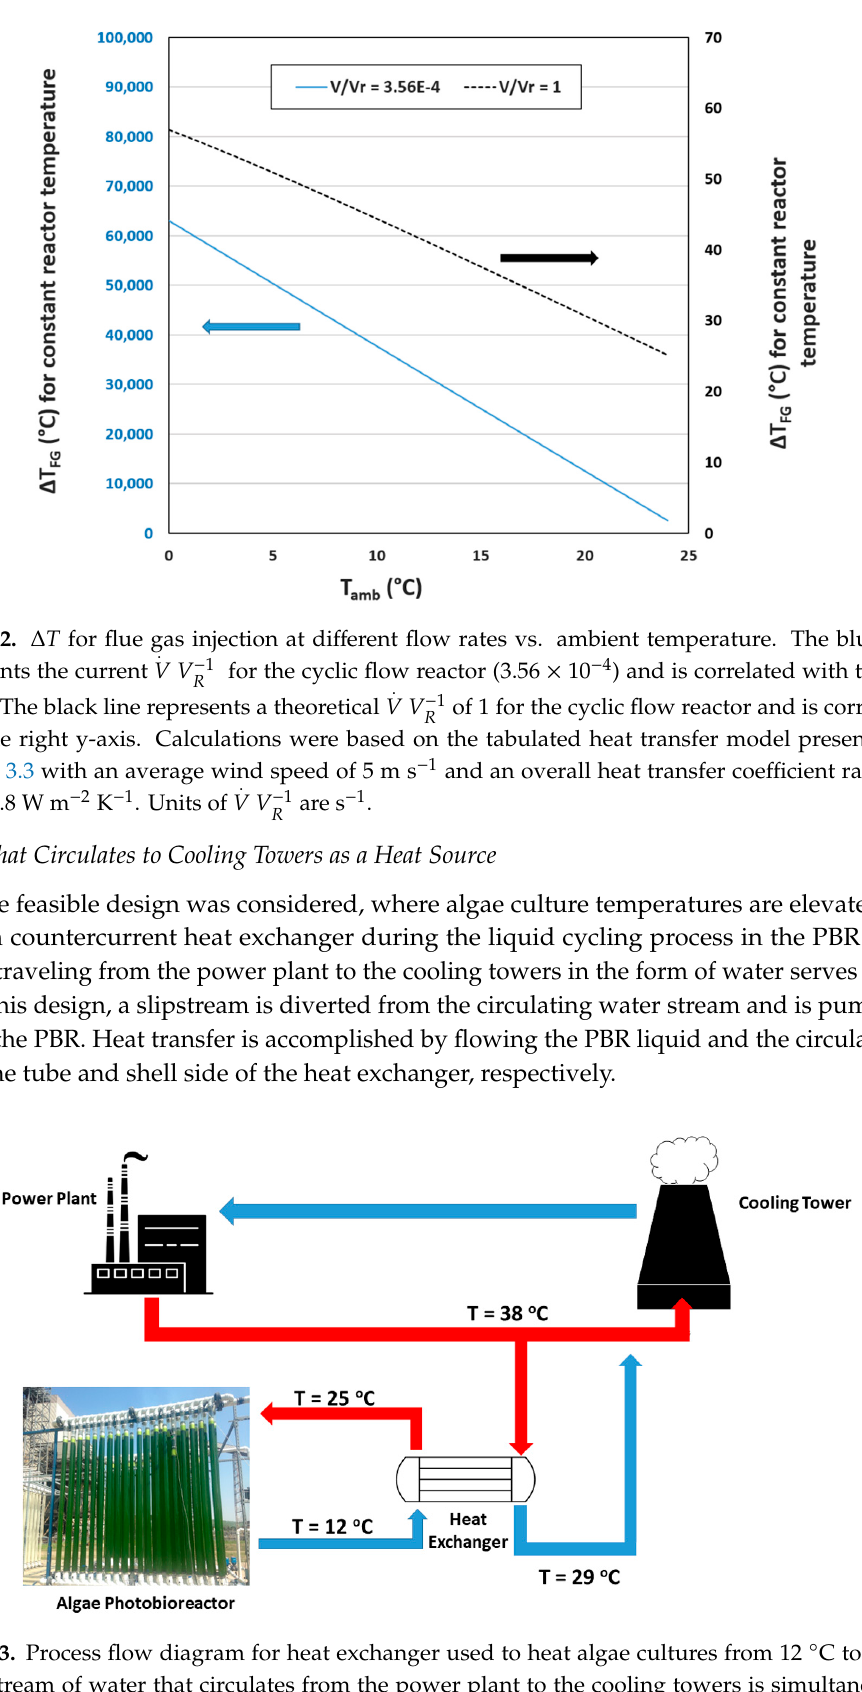
Figure 2. ∆𝑇 for flue gas injection at different flow rates vs. ambient temperature. The blue line represents the current 𝑉(cid:4662) 𝑉 (cid:3019)–(cid:2869) for the cyclic flow reactor (3.56 × 10 –4 ) and is correlated with the left y- axis. The black line represents a theoretical 𝑉(cid:4662) 𝑉 (cid:3019)–(cid:2869) of 1 for the cyclic flow reactor and is correlated with the right y-axis. Calculations were based on the tabulated heat transfer model presented in Section